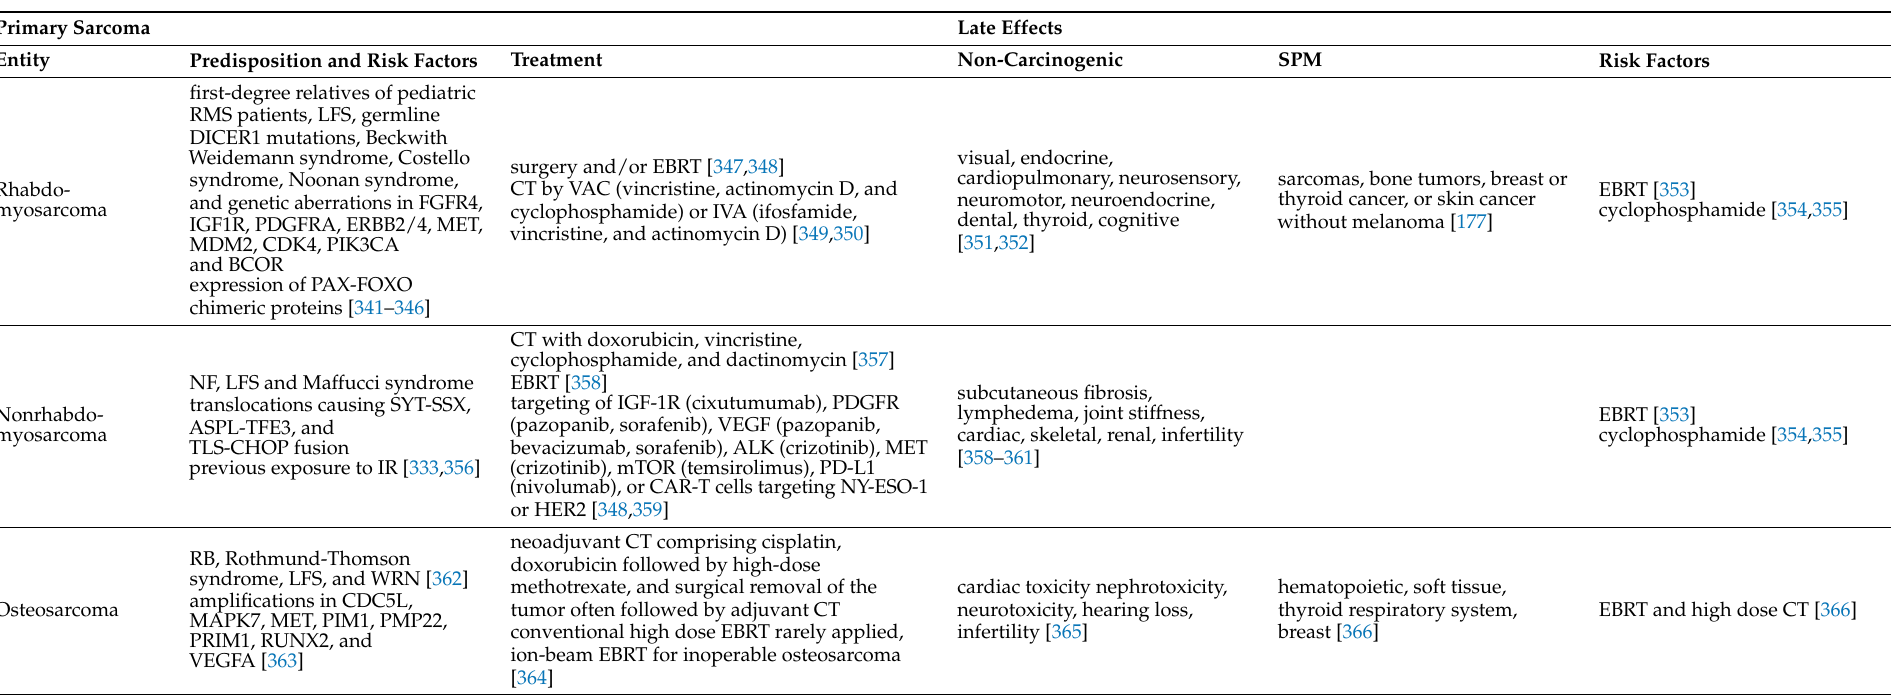
Table 3. Overview of major primary childhood sarcomas, risk factors for their development, current treatments, non-cancerous late effects, most common second primary malignancies, and risk factors for their